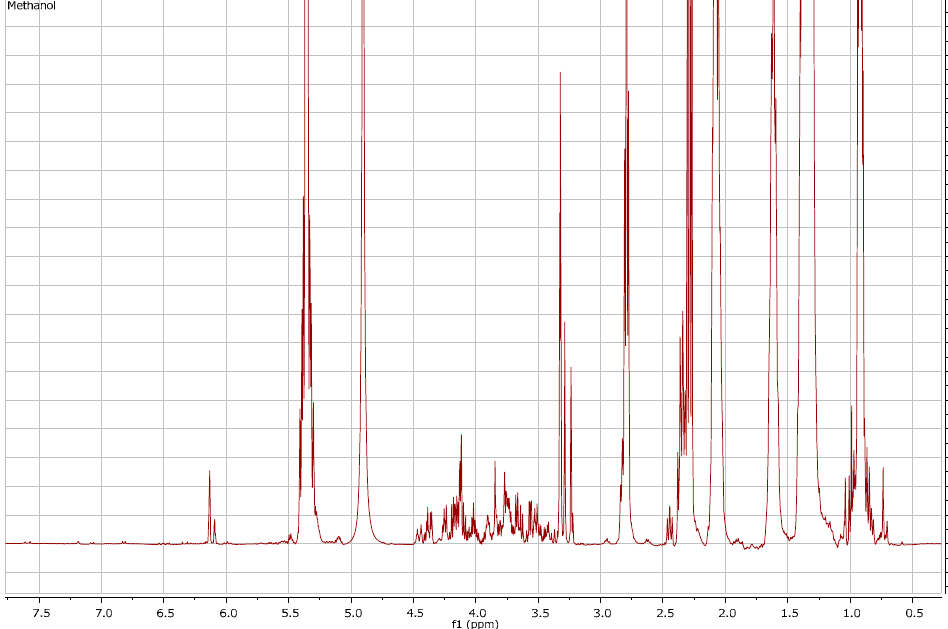
Foods 2020 , 9 , x FOR PEER REVIEW